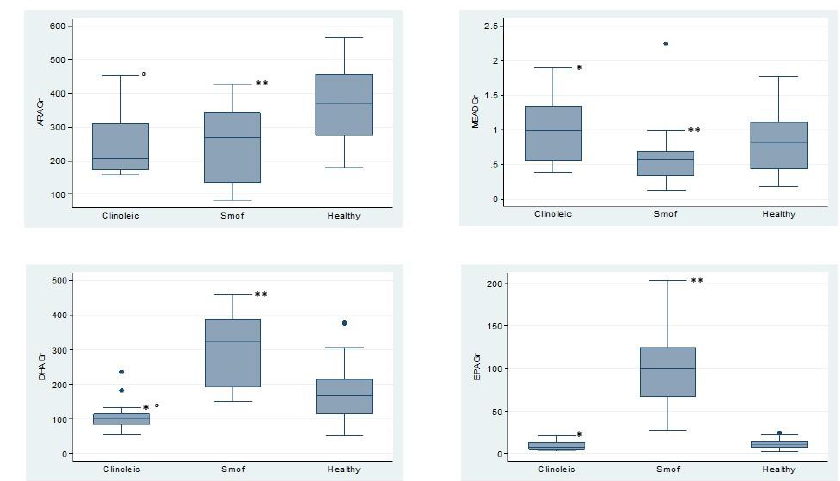
Figure 2. RBC PUFAs in patients on SMOF or Clinoleic and healthy children: Mead acid (MA); arachidonic acid (ARA); eicosapentaenoic acid (EPA); docosahexaenoic acid (DHA). · p -value for the differences between 3 data series are reported in each panel. Differences between 2 groups: ** p < 0.01 SMOF vs. Healthy; * p < 0.01 SMOF vs. Clinoleic; ° p < 0.01 Clinoleic vs. Healthy.